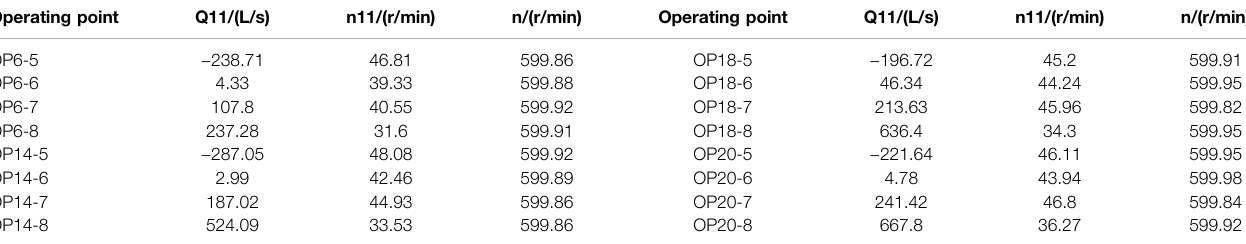
TABLE 7 | Table of operating point in turbine mode. (A positive value represents the direction of the turbine, and a negative value represents the direction of the pump). Operating point